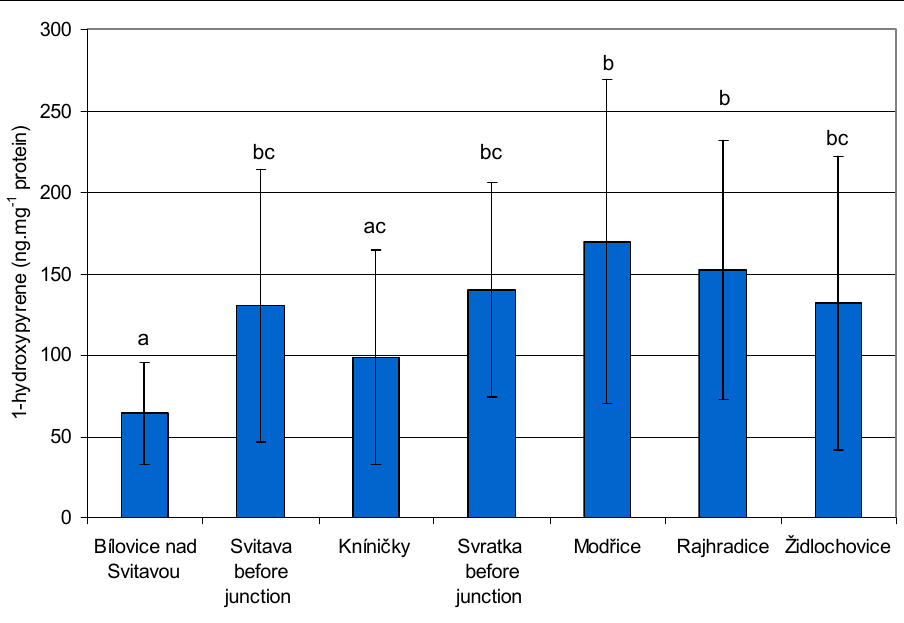
Figure 5. Content (mean ± standard deviation) of 1-hydroxypyrene in chub bile samples at monitored locations. Significant differences ( P < 0.05) are indicated by alphabetic